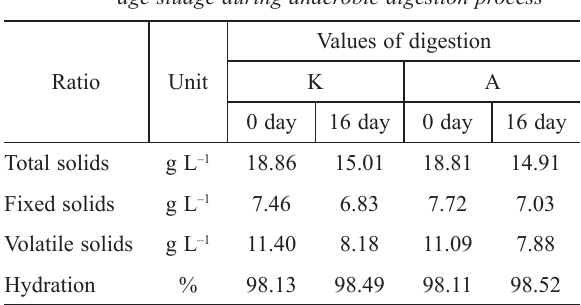
Table 3 – Changes in the physicochemical properties of sew- age sludge during anaerobic digestion process